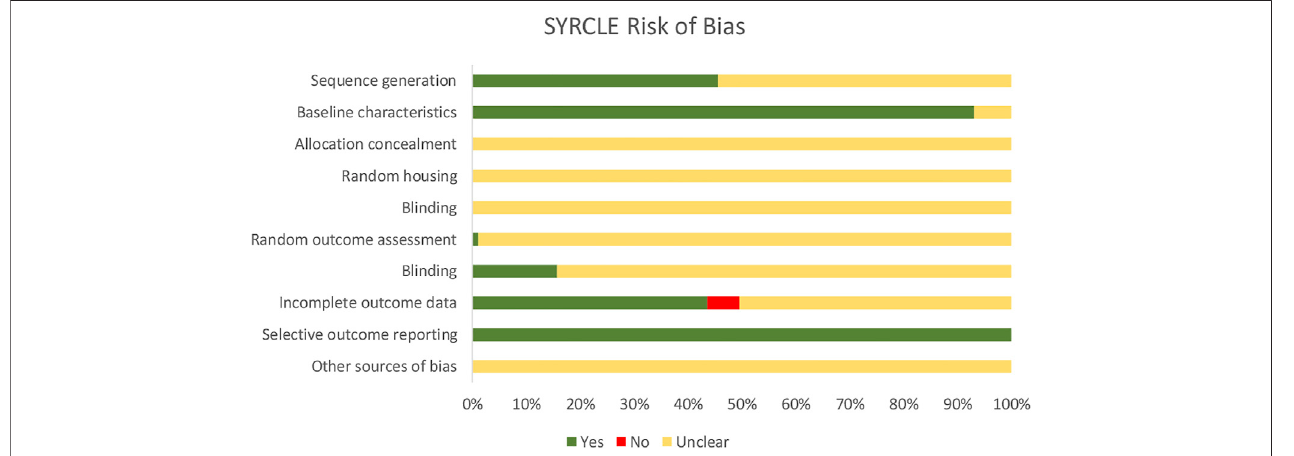
FIGURE 2 | Assessment of the risk of bias (SYRCLE) for selected studies, presented as the percentages of the total.